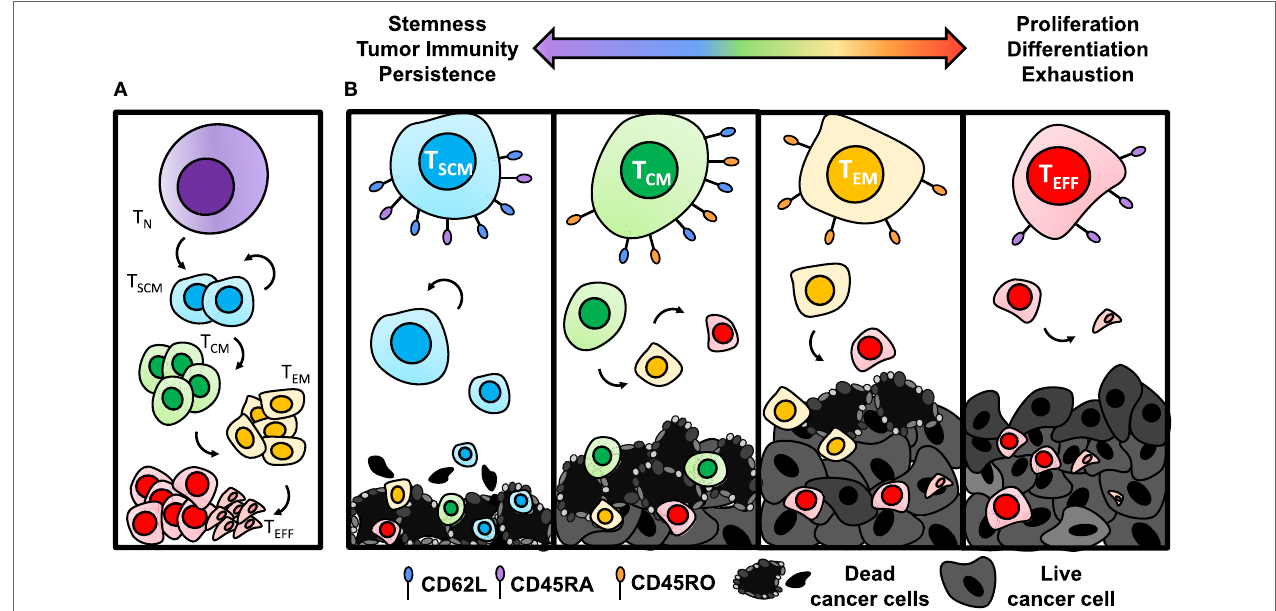
FigURe 3 | Antitumor efficacy of memory CD8 + T cell subsets diminishes with differentiation. (A) Once activated with cognate antigen, CD8 + T cells progressively differentiate from stem-cell memory (SCM), with the highest capacity of self-renewing properties, to central memory (CM), effector memory (EM), and finally to terminal effector (EFF) phenotypes. (B) Antitumor immunity of T SCM cells is enhanced due to establishing long-term memory responses to tumor antigens and heightened ability to persist. As cells become more differentiated through the T CM , T EM , and T EFF stages, they lose capacity for self-renewal and become exhausted, resulting in poor antitumor